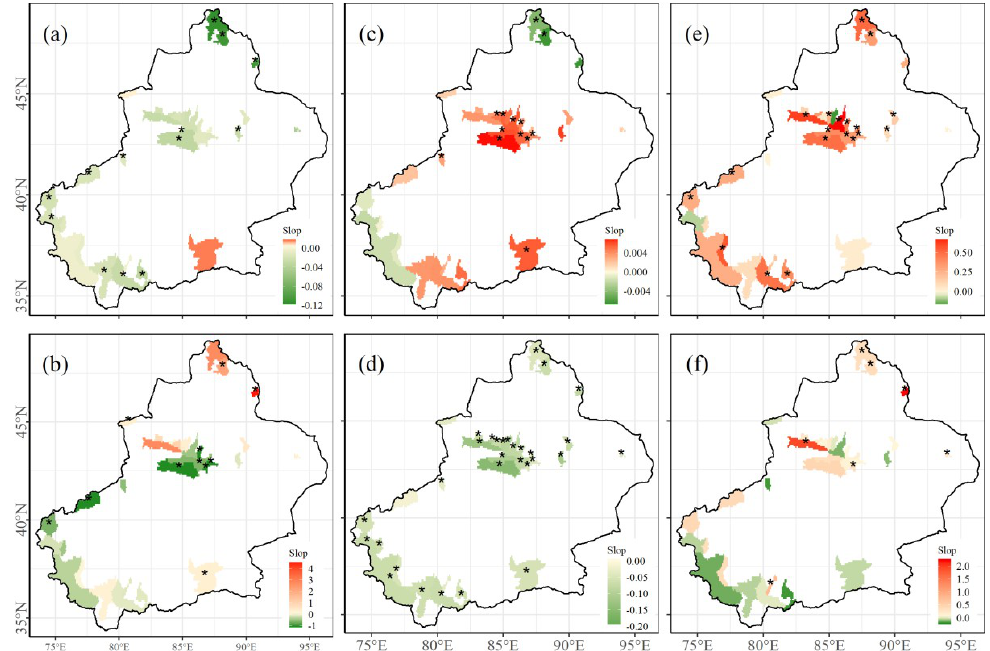
Figure 5. The distribution of slope coefficient (Slop) between temperature and SCF ( a ), runoff and SCF ( b ), temperature and precipitation ( c ), temperature and ratio of snowfall to precipitation (S/P) ( d ), rainfall and runoff ( e ), snowfall and runoff ( f ).